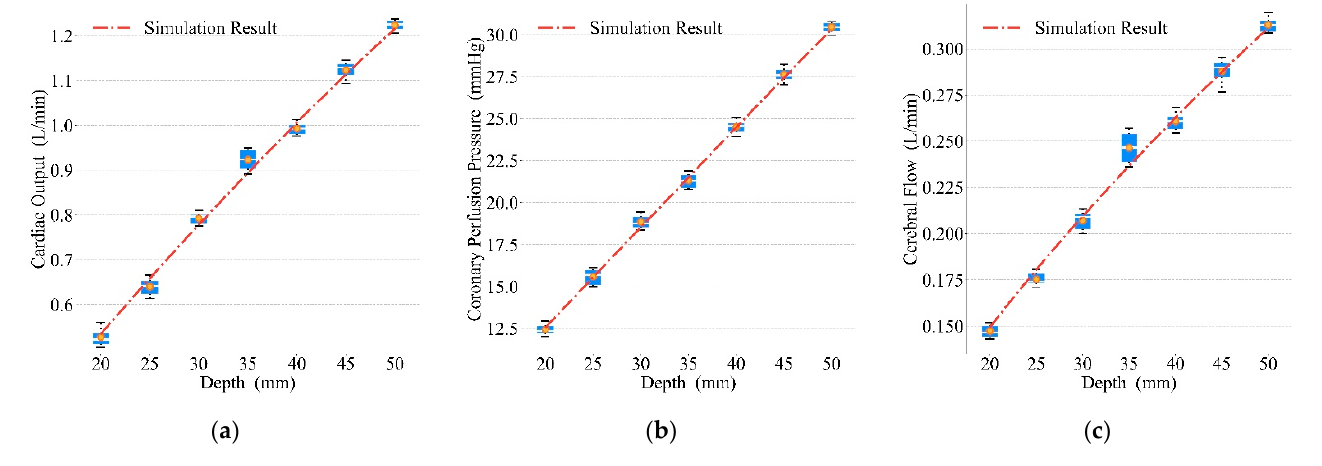
Figure 15. Relationship between depths and blood circulation results: ( a ) CO, ( b ) CPP, ( c ) CF.